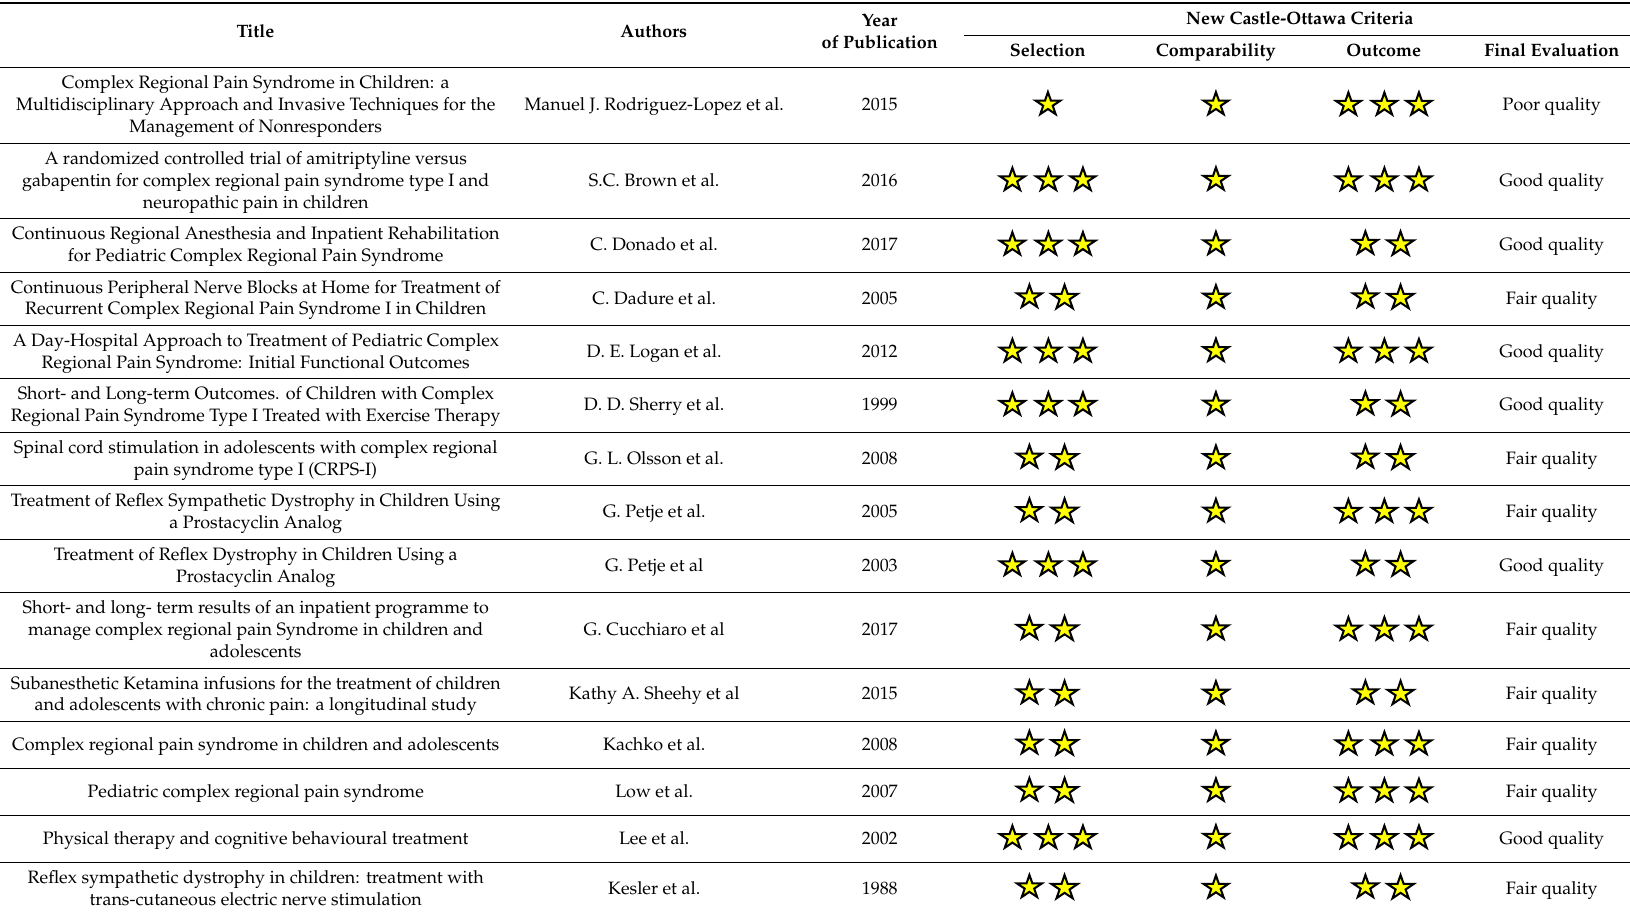
Table A1. Risk of bias assessment.